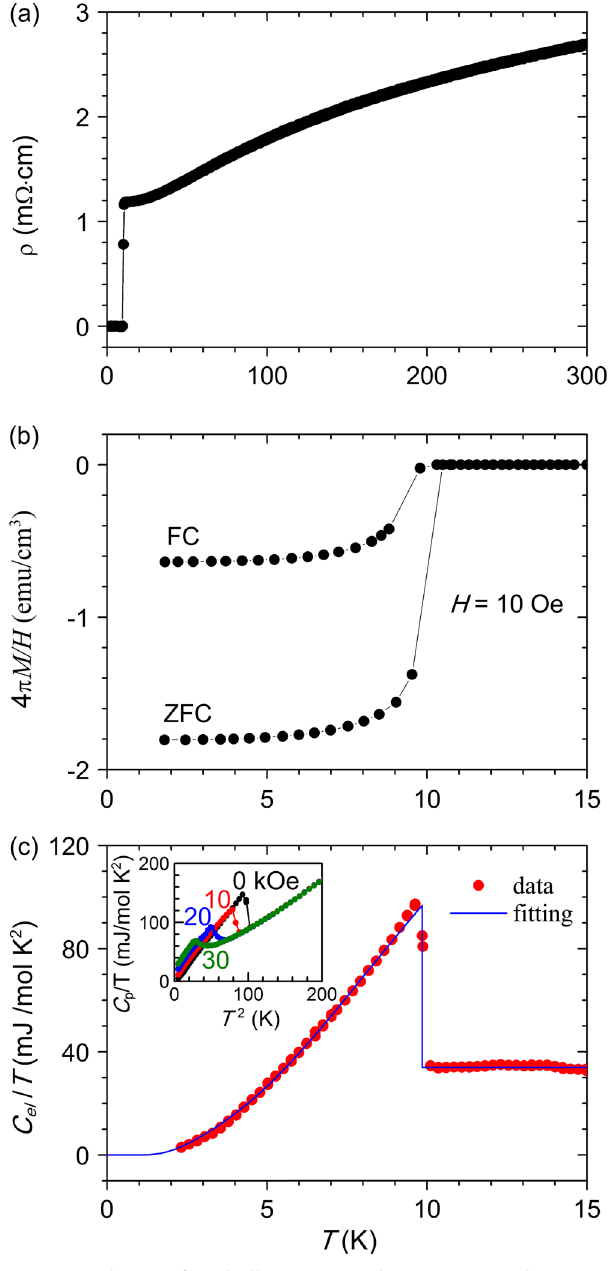
Fig. 3 Evidence for bulk superconductivity in Nb 5 Ir 3 O. a Temperature-dependent resistivity at zero magnetic fi eld. b Mag- netic susceptibility curve under an applied fi eld of H = 10 Oe. c The electronic contribution to speci fi c heat fi tted according to a two-gap model. Inset is the speci fi c heat measurement with and without magnetic fi